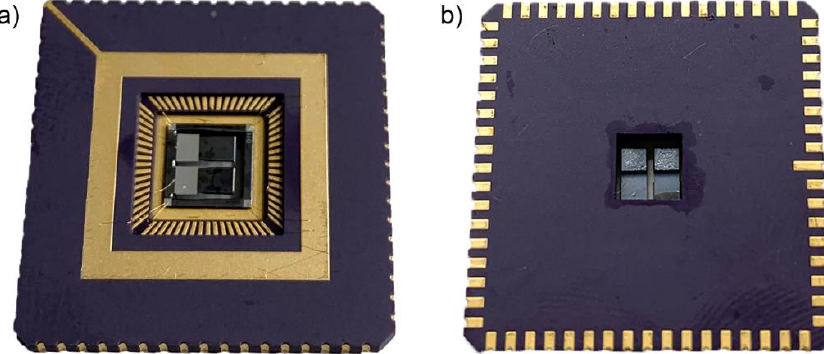
Figure 3. Fabricated PEH mounted in LCC68: ( a ) top view; ( b ) bottom view showing hole and PEH mass.